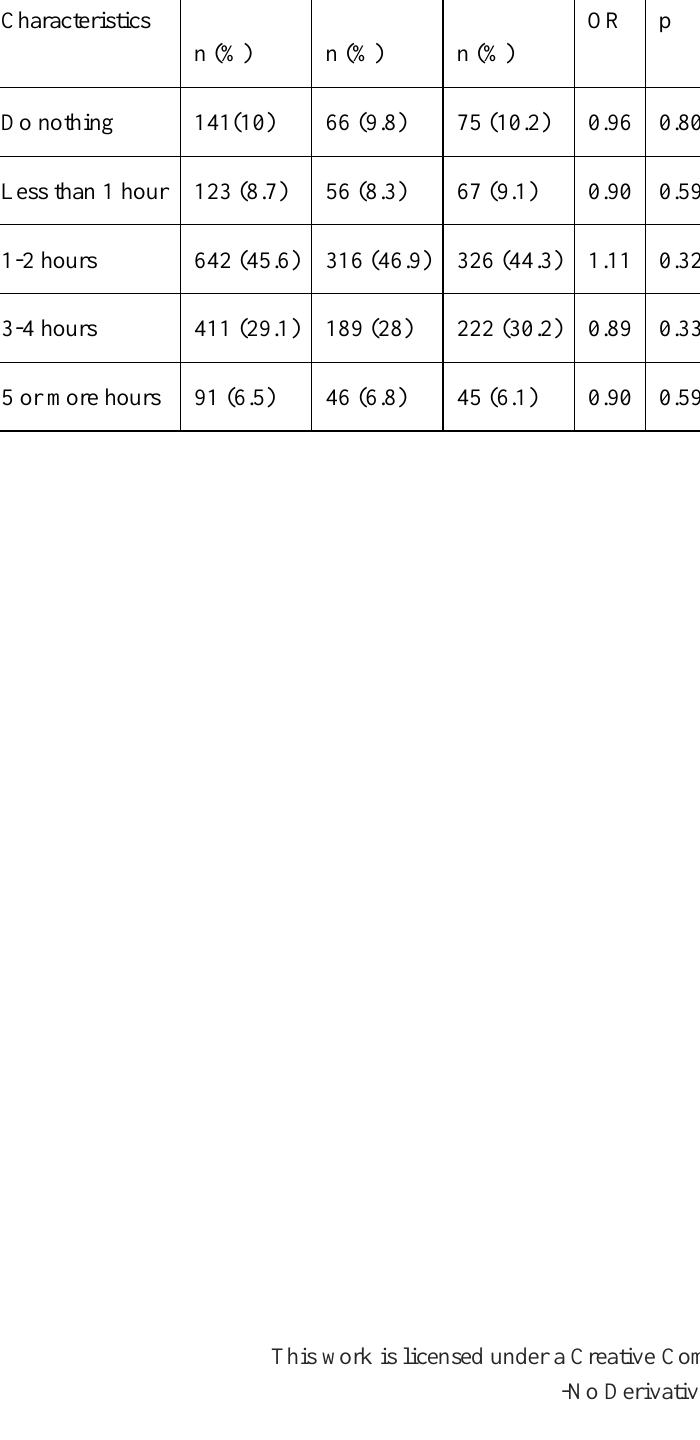
Table 4: Television and, computer and computer game use